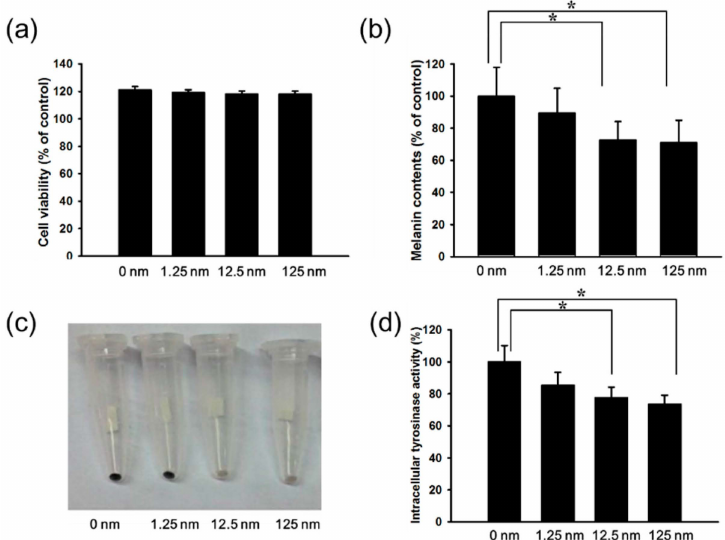
Figure 2. Effects of hinokitiol on cell viability and melanin production in B16F10 cell. B16F10 cells were treated with indicated concentrations of hinokitiol for 48 h. ( a ) Cell viability was measured by WST-1 assay; ( b ) Effect of hinokitiol on cellular melanin content; ( c ) Photograph of precipitated B16F10 melanoma cells. Cells were incubated for 48 h with (1.25–125 nM) and without hinokitiol; ( d ) Tyrosinase activity was measured. * p < 0.05 (mean ˘ SD, n = 6). Each experiment was repeated three times with similar